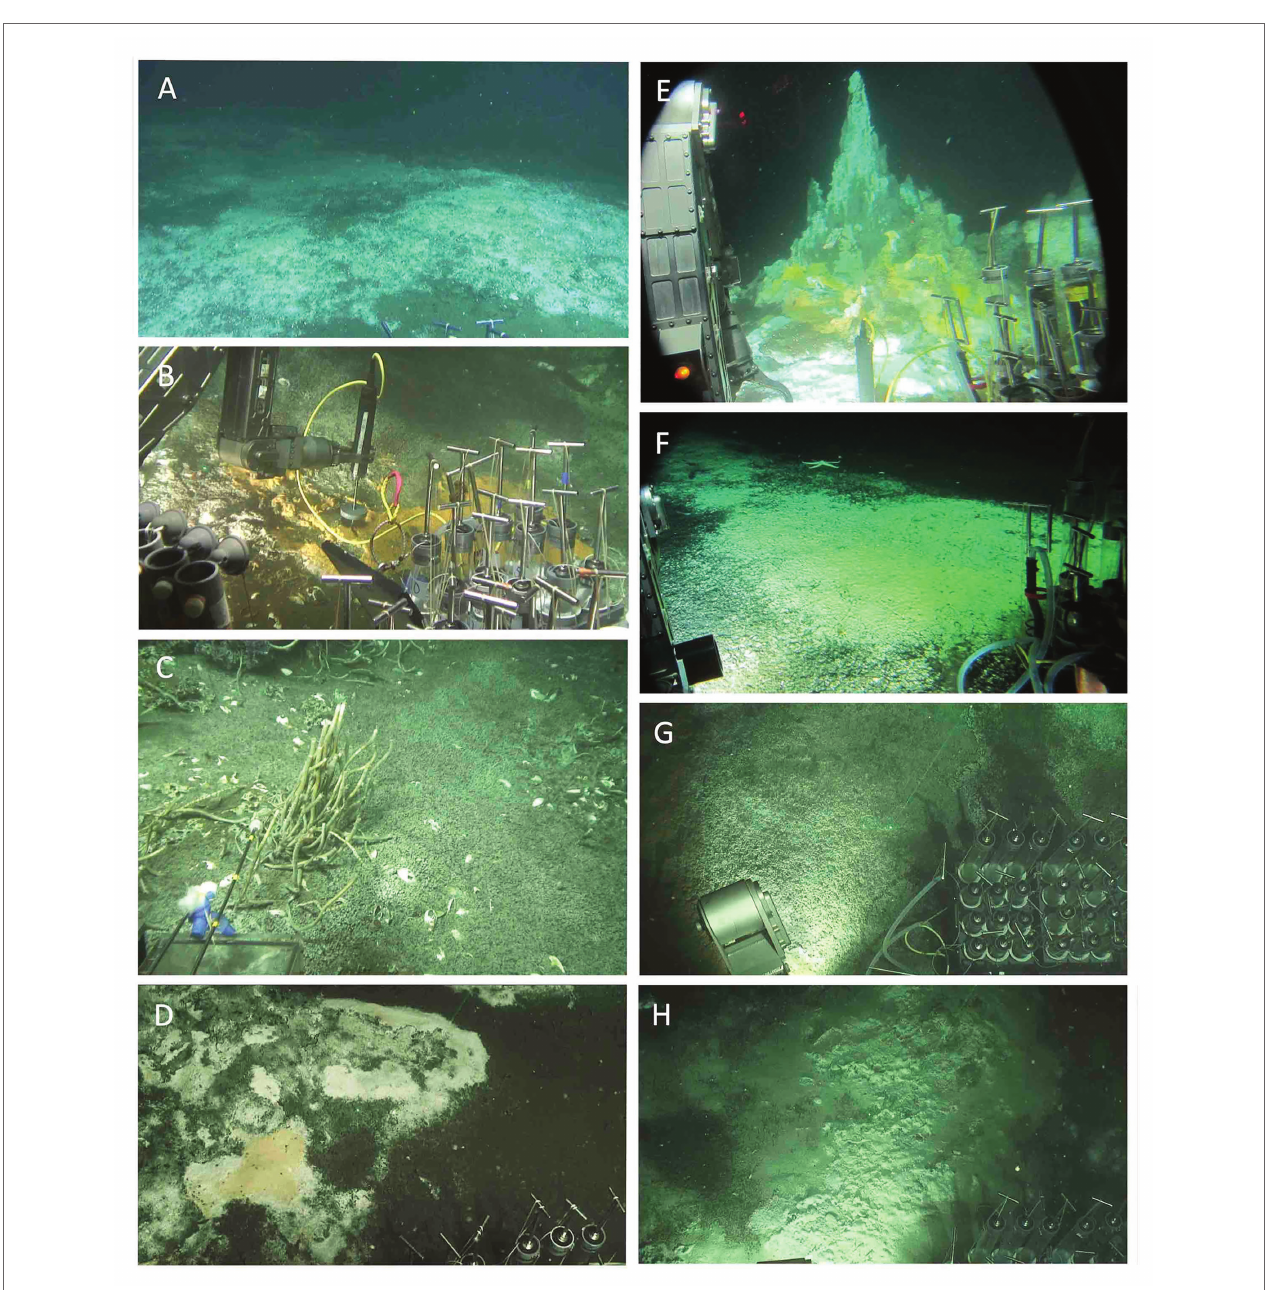
FIGURE 2 | Sampling sites for microbial and/or biogeochemical analyses. (A) Extensive white mat at Mat Mound Massif. Dive 4861. (B) Hydrothermal sediment with orange Beggiatoaceae mat, Mat Mound Massif. Dive 4862. (C) Cold seep site “active site” at Octopus Mound. Dive 4867. (D) Hydrothermal sediment with orange Beggiatoaceae mat at Mat Mound Massif. Dive 4869. (E) Summit and slopes at Cathedral Hill. The cores are from the white, fluffy mat area at the bottom of the photo. Dive 4870. (F) Temperate Aceto Balsamico mat with lime-yellow sulfur precipitates. Dive 4870. (G) Temperate “site 2” mat-covered sediment at Northern Towers. Dive 4871. (H) Hot “site 3” mat-covered hydrothermal sediment at Northern Towers. Dive 4871. The sites were photographed from inside Alvin (dives 4862, 4867, 4870) or documented as Alvin screen grabber images (dives 4861, 4869, 4871). Images courtesy of Alvin group,